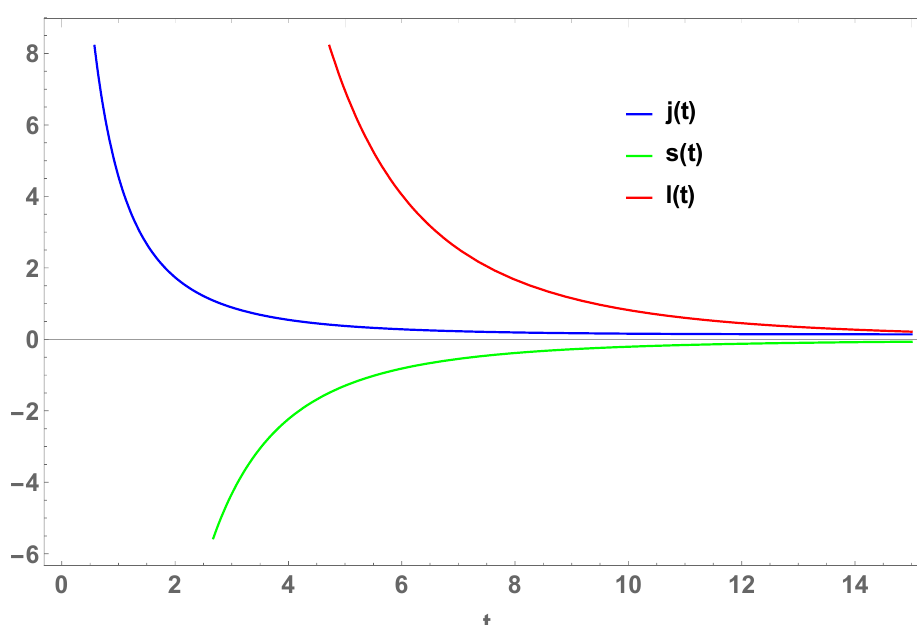
Figure 4. Behaviour of the jerk parameter ( j ) with respect to cosmic time t for different values of β with α = − 1.5, b =